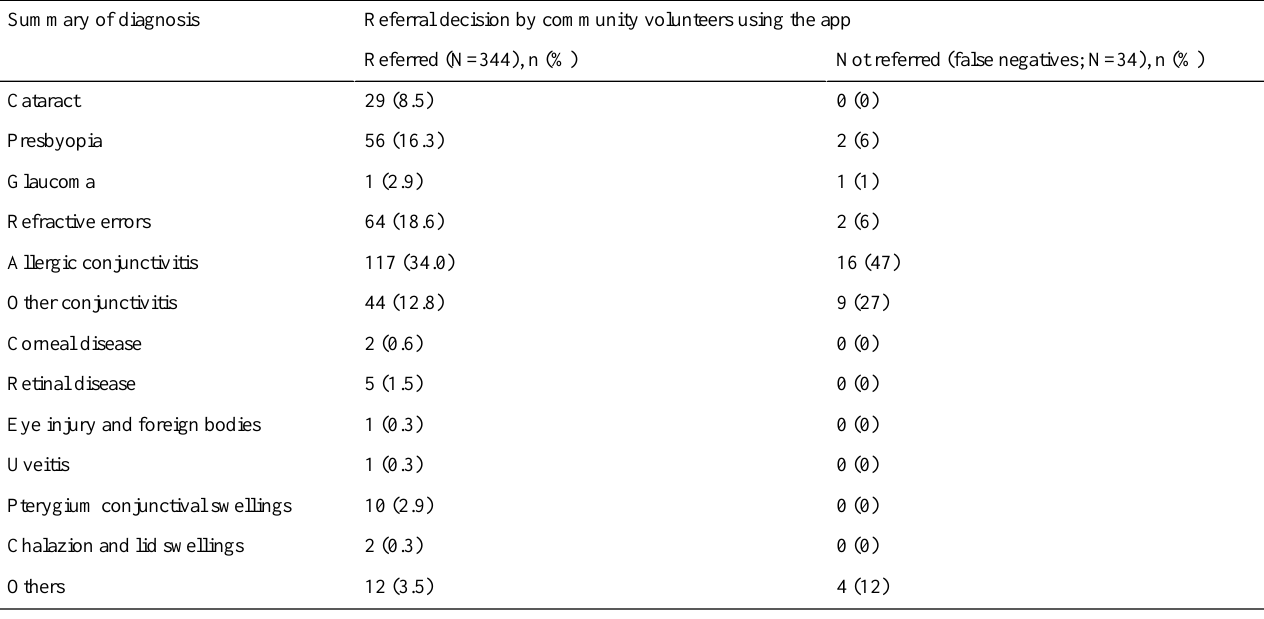
Table 3. Clinical diagnosis of the participants referred by the ophthalmic clinical officer and referral decisions by community volunteers using the Peek Community Screening app. Referral decision by community volunteers using the appSummary of